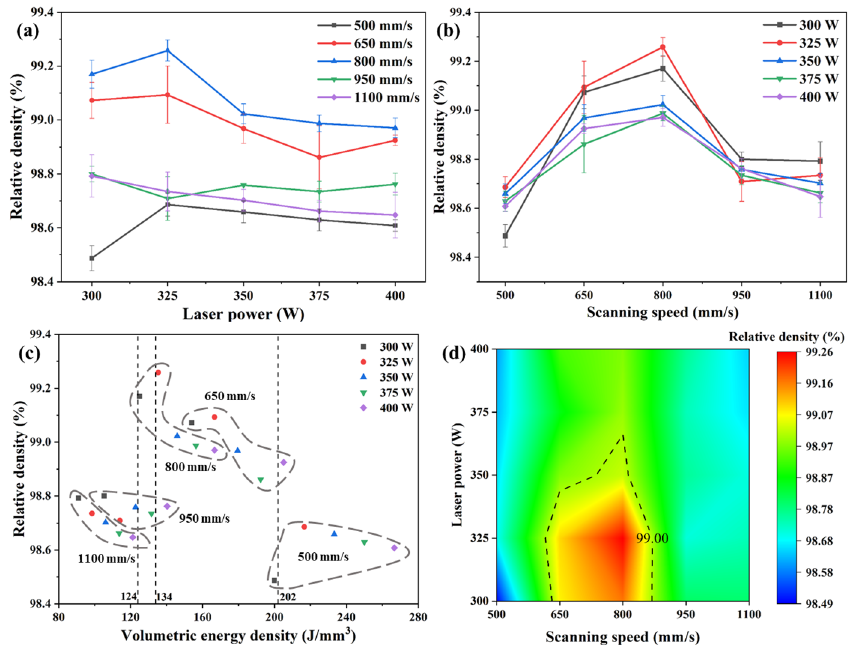
Figure 2. The relative density of Cu–Cr–Nb–Ti alloy manufactured using different process parameters: ( a ) the change curve of the relative density with the laser power under different scanning speeds, ( b ) the change curve of the relative density with the scanning speed under different laser powers, ( c ) the relationship between the VED and the relative density (symbols of the same color represent samples manufactured using the same laser power, and the dotted line frame represents samples manufactured at the same scanning speed), and ( d ) the process window of the Cu–Cr–Nb–Ti alloy (the process parameters of the as-built samples with a relative density greater than 99% are shown in the dashed frame).